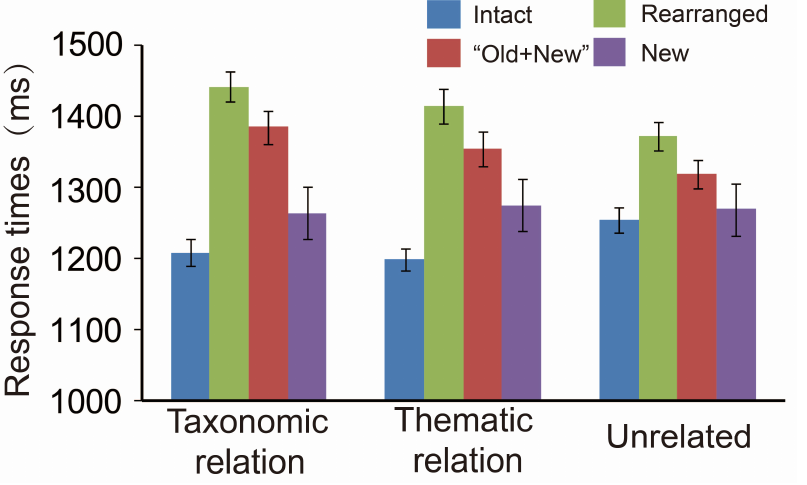
Figure 3. The response times (in ms) as the function of pair type by semantic relation. Bars represent the standard errors.